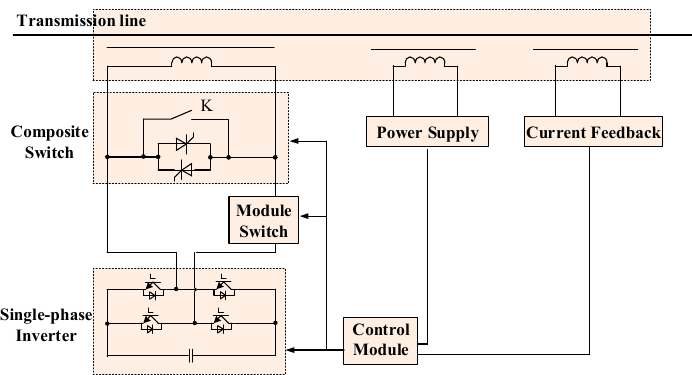
Figure 3. Schematic representation of a DPFC.